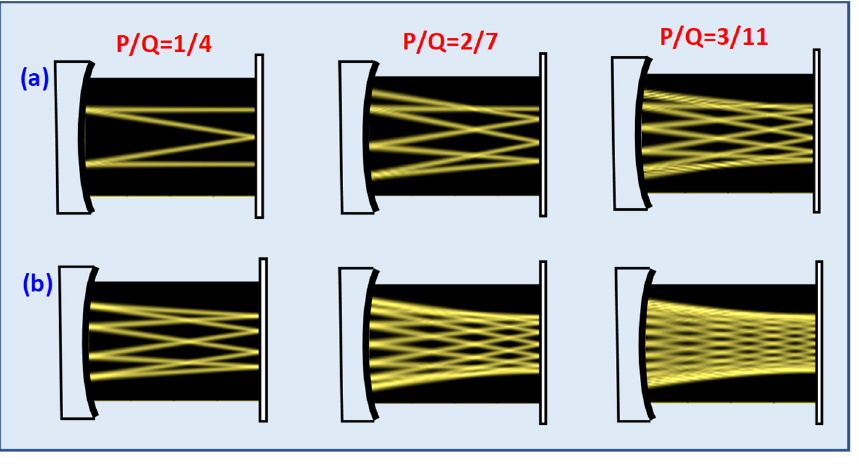
(cid:12) (cid:12) (cid:12) (cid:12) 2 2 Ψ + Ψ − (cid:12) (cid:12) (cid:12) (cid:12) ( r ) + ( r ) from Equation (20) with N = 100, (cid:12) (cid:12) (cid:12) (cid:12) 0, N 0, N